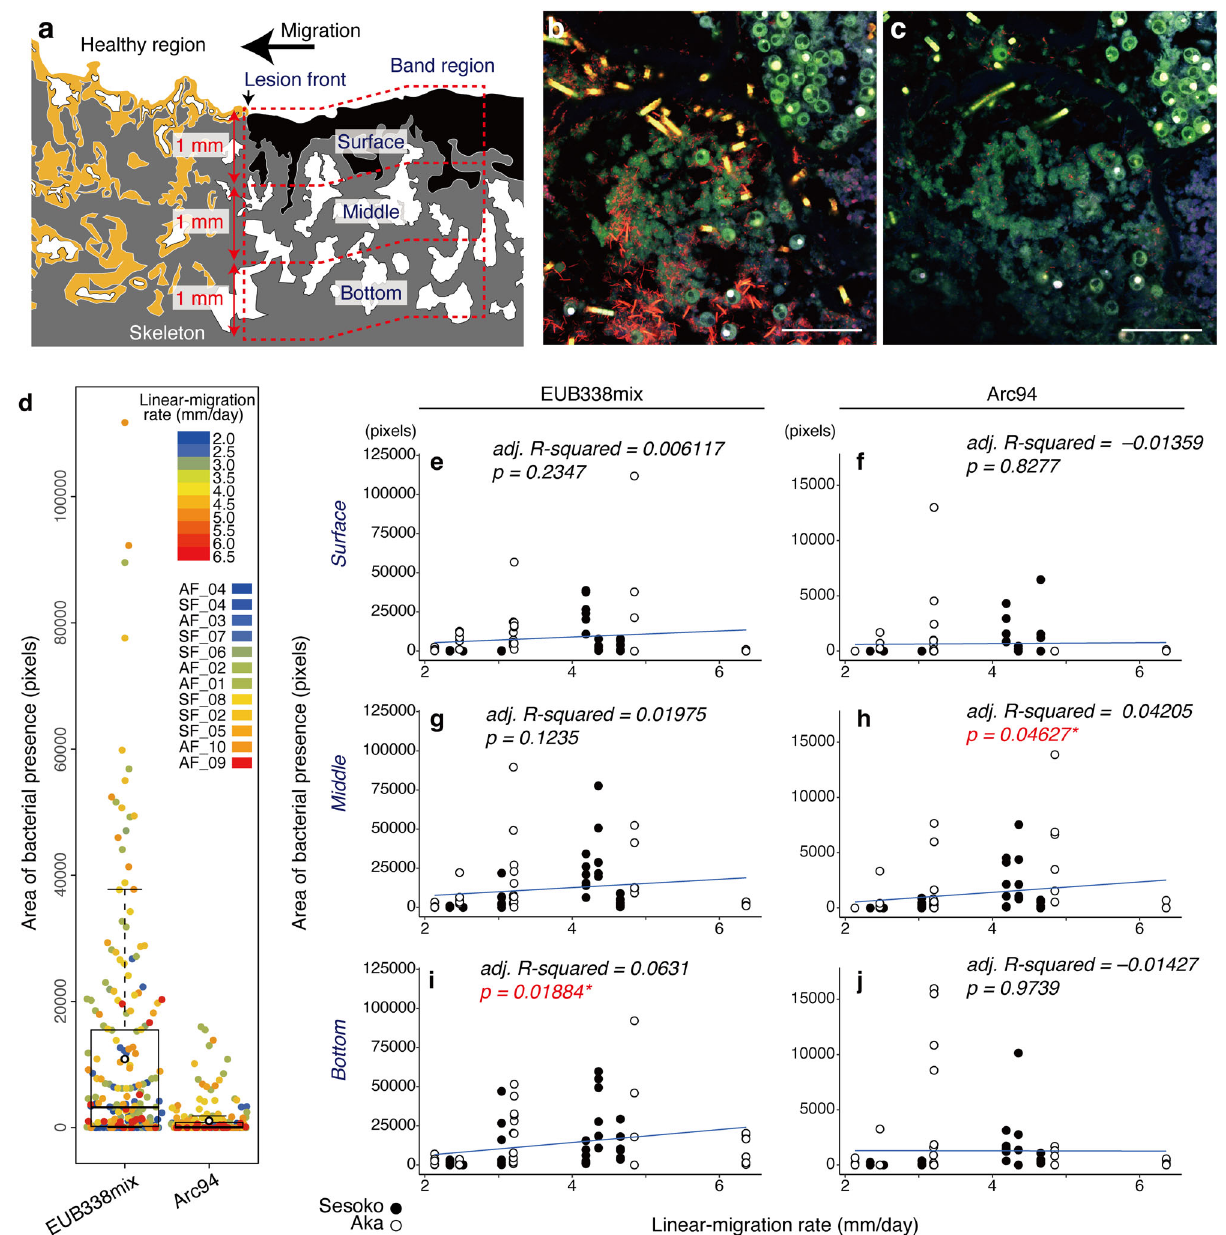
Fig. 6 Quantitative area analysis of the spatial bacterial localizations of all bacteria (except fi lamentous cyanobacteria) and Arcobacteraceae in BBD mats. Schematic illustration showing three layers (surface, middle, and bottom; each vertical interval is 1 mm) in BBD mats for the spatial analysis ( a ). Confocal merge micrographs showing spatial bacterial localization (red) of all bacteria ( b ) and Arcobacteraceae ( c ) in two serial sections; hybridized with EUB338mix and Arc94 probes, respectively. Scale bars indicate 50 µm ( b and c ). Dot plots merged with box plot showing the entire area of both all bacteria (except fi lamentous cyanobacteria) and Arcobacteraceae detections in the various migration rates (depicted by color; the sample IDs ‘ AF ’ and ‘ SF ’ indicate collection from Aka Island and Sesoko Island, respectively) ( d ). Box plot center lines represent the median values, box limits are the 25 and 75% of the sample, and upper and lower quartiles represented in bars are 5 and 95% of the sample ( d ). Linear regressions showing the associations between migration and areas of bacterial presence (all bacteria [ e , g , and i ] and Arcobacteraceae [ f , h , and j ]) in the surface ( e and f ), middle ( g and h ), and bottom layers ( I and j ). Signi fi cant correlation is shown in red, with * p value <